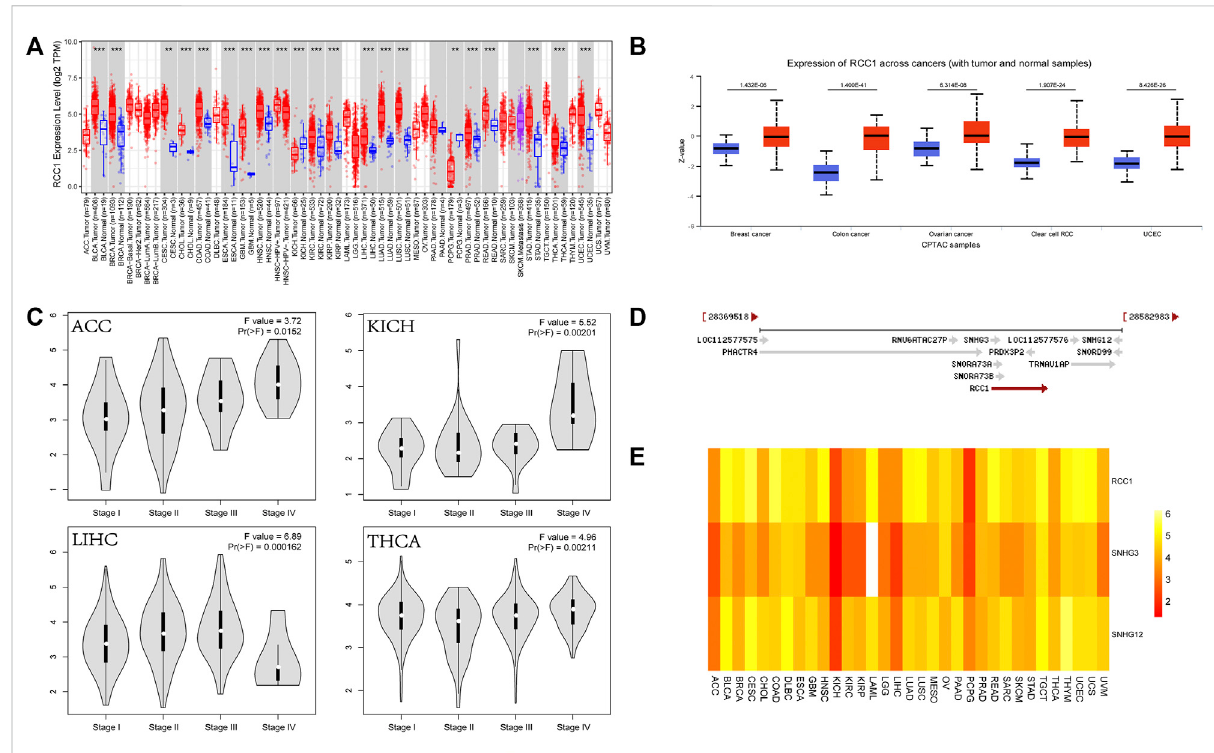
FIGURE 1 Expression of RCC1 and correlation of RCC1/SNHG3/SNHG12 in pan-cancer. (A) RCC1 expression in pan-cancer. (B) Protein expression levels of RCC1 in selected cancers. (C) Differential expression of RCC1 in ACC/KICH/LIHC/THCA in staging. (D) Relationship of RCC1/SNHG3/SNHG12 on chromosomal location. (E) Comparison of RCC1/SNHG3/SNHG12 expression in pan-cancer. ** p < 0.01; *** p <